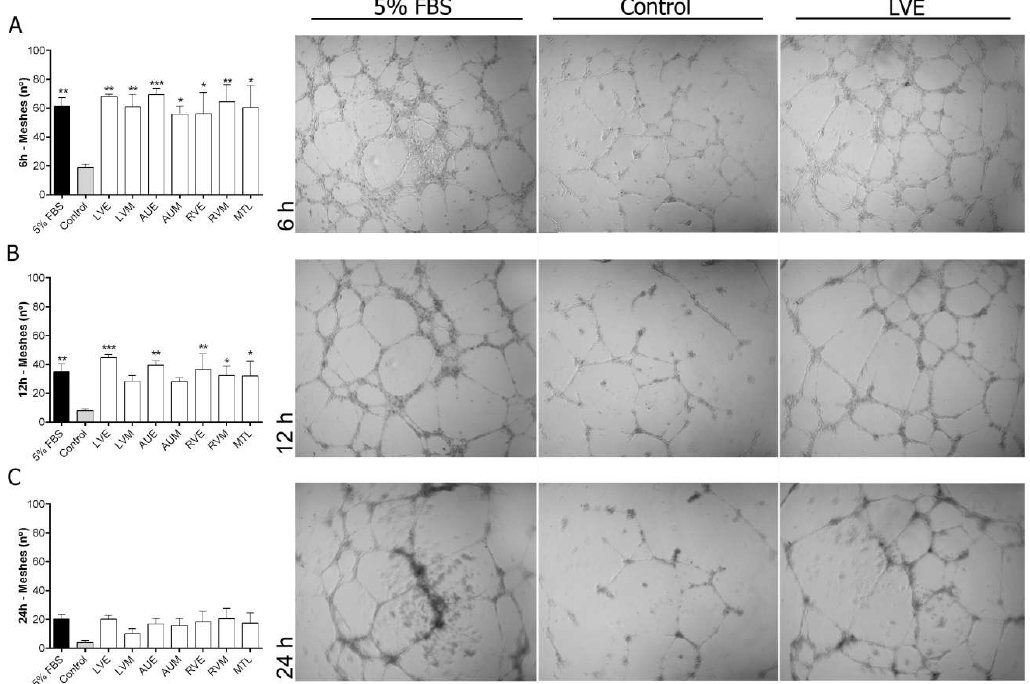
Figure 6. In vitro angiogenesis assay of HUVECs cultured for 24 h on a Matrigel layer under the influence of hH-EVs derived from cardiac regions. Representative images and analysis of the number of meshes formed after 6 h ( A ), 12 h ( B ) and 24 h ( C ). * p < 0.05 vs Control; ** p < 0.01 vs Control; *** p < 0.001 vs Control, 4 ×